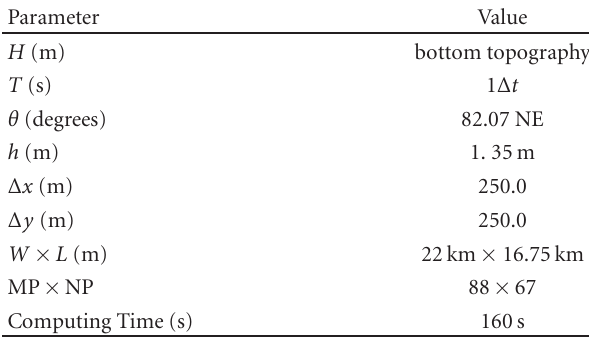
Table 2: Parameters used for the coastal area of the